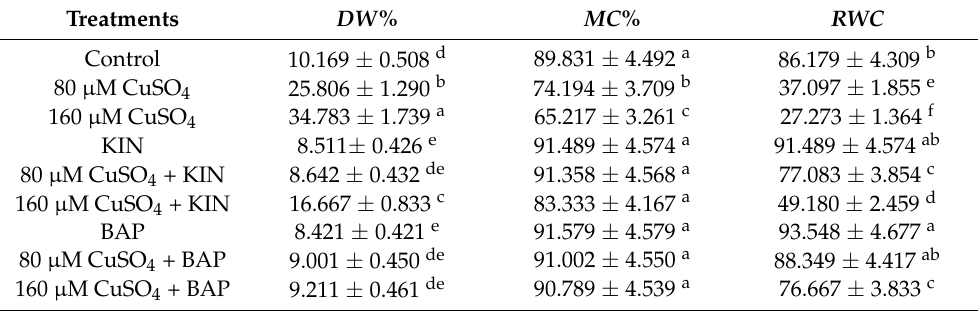
Table 1. Dry weight percentage ( DW %), moisture content percentage ( MC %) and relative water content ( RWC ) in the cotyledonary leaves of R. communis after 6 day of exposure to CuSO 4 (80 and 160 µ M) and cytokinin (KIN and BAP) treatments in Hoagland’s nutrient medium. Values are the mean ± SE of three independent experiments. Different alphabetical letters indicate significant differences between treatments according to one-way ANOVA (Duncan’s test p ≤ 0.05).